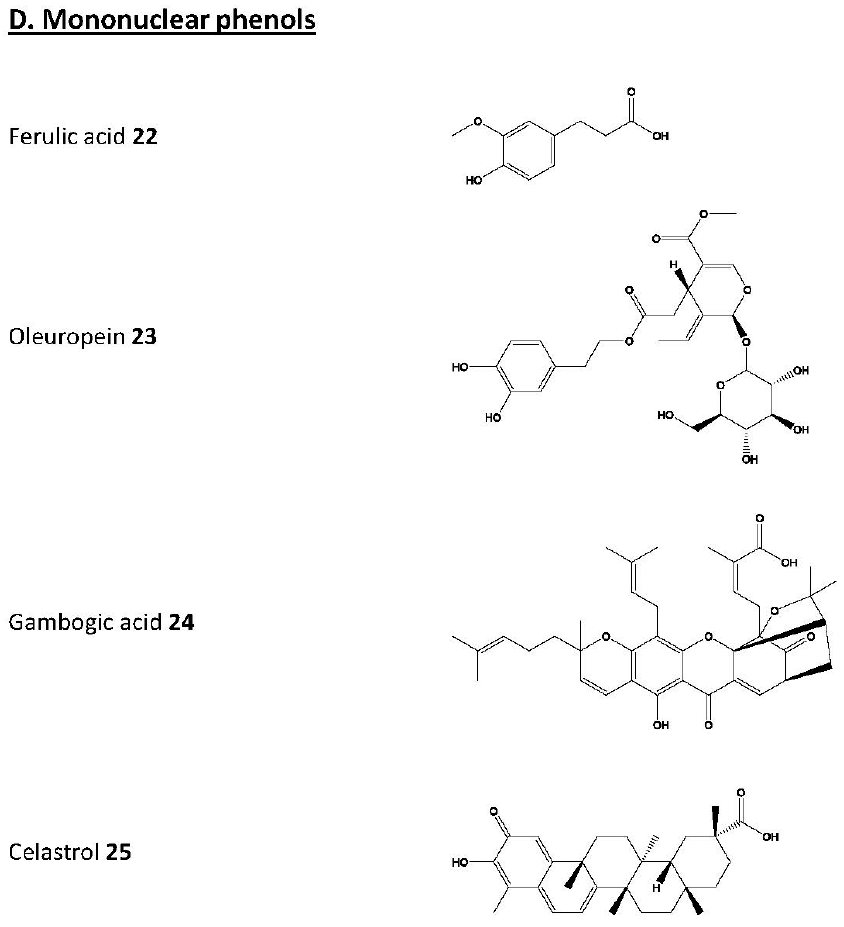
Figure 1. Chemical structures of the compounds discussed in the text. ( A ) catechins; ( B ) flavonols; ( C ) binuclear phenolic structures and ( D ) mononuclear phenolic compounds.